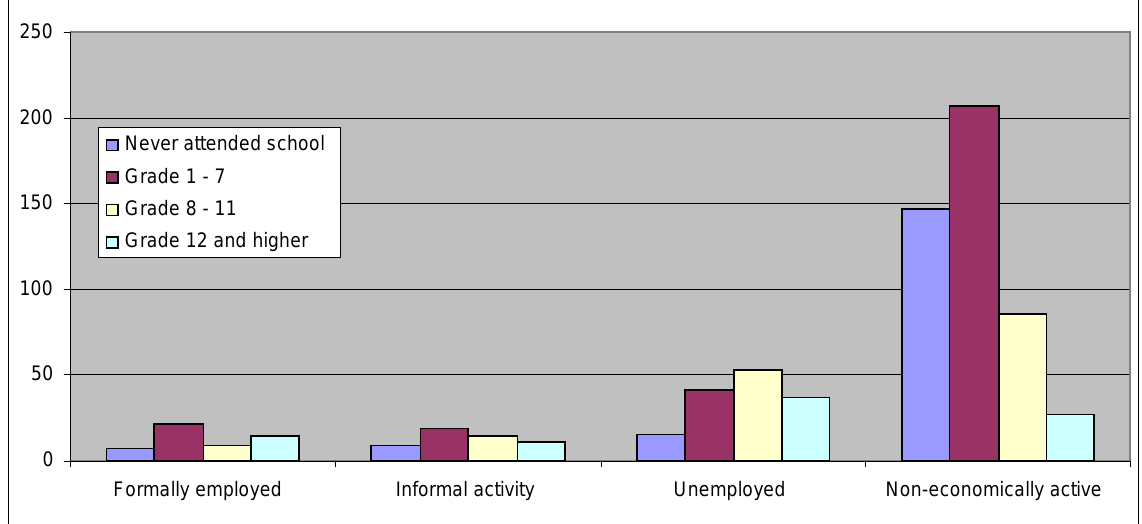
2007 Source: Table